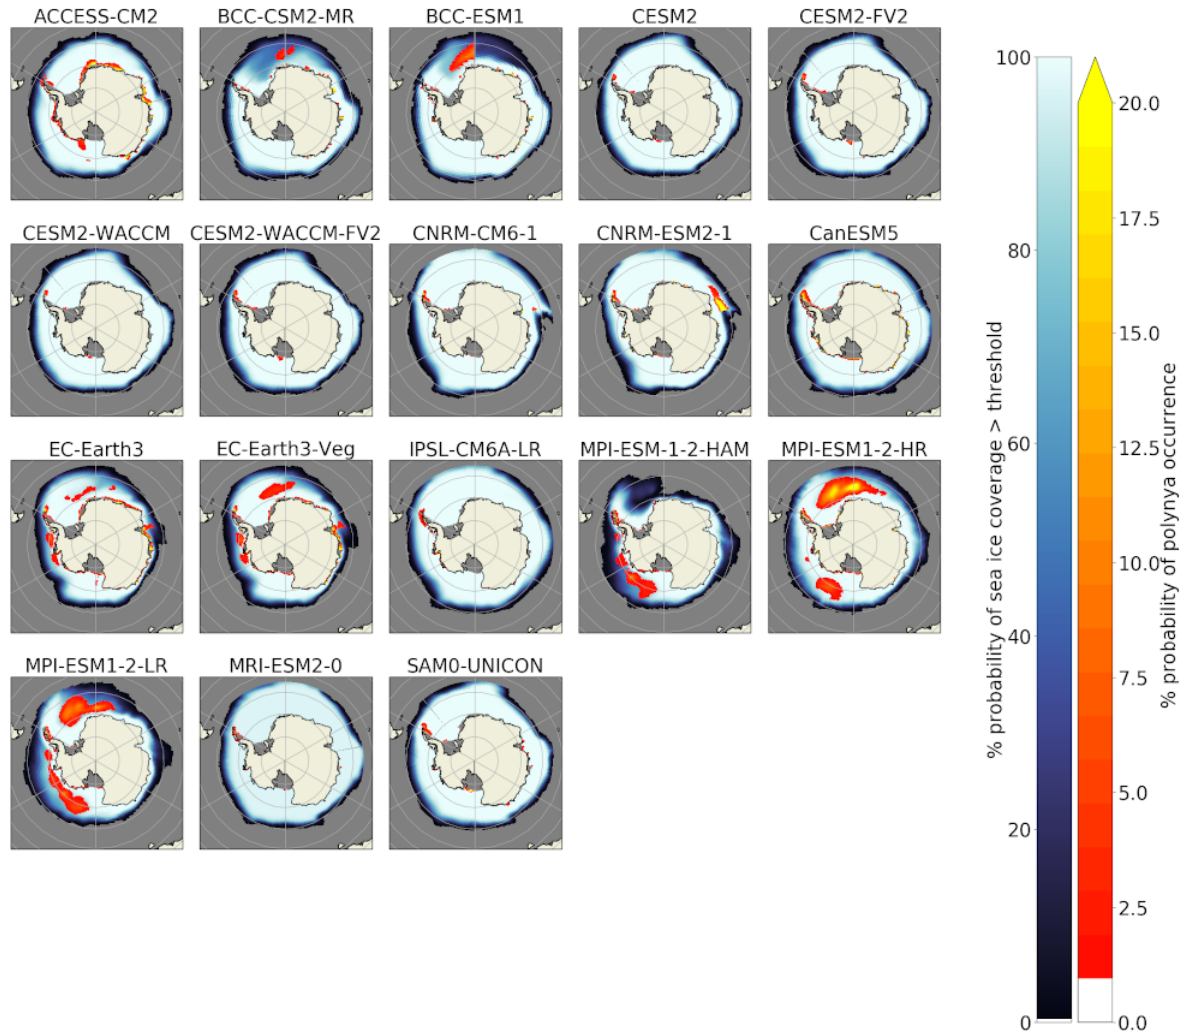
Figure A4. Spatial distribution of polynyas in the CMIP6 models, computed from the daily sea ice concentration output for September. The red-to-yellow colours indicate the number of years where polynyas occurred within the 165 years of the historical model run for each grid cell. The blue colours show the average sea ice concentration (in